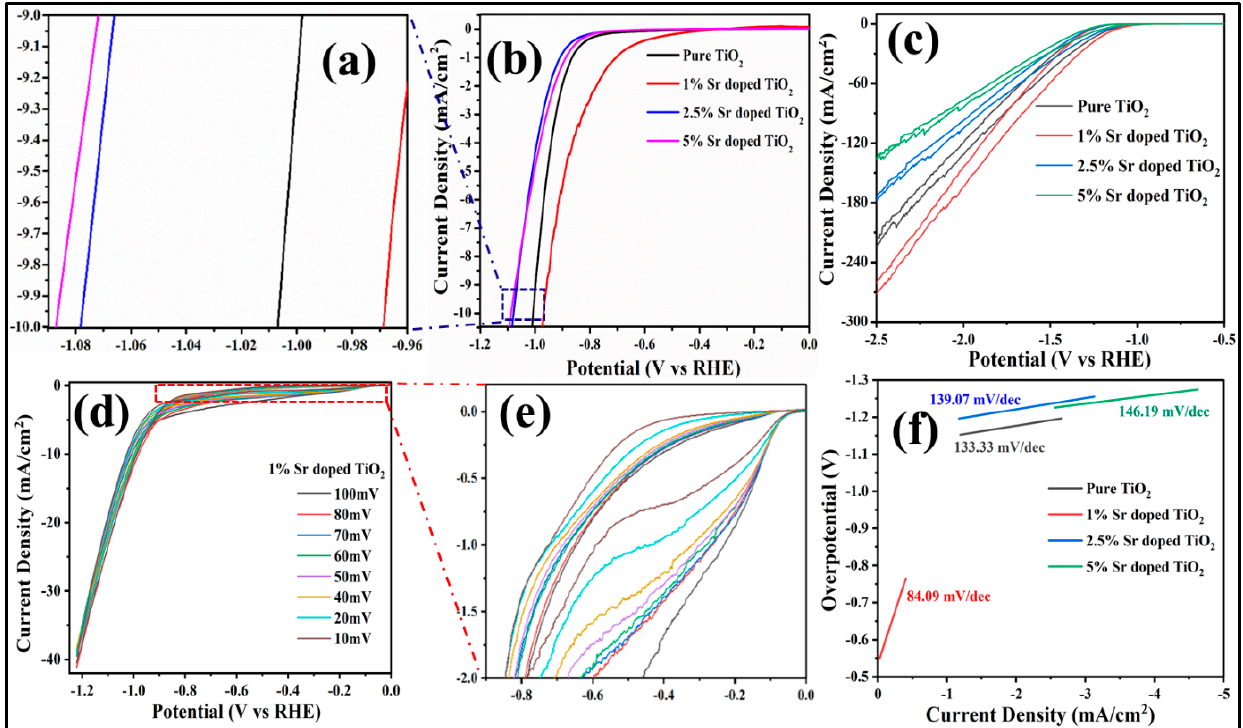
Figure 11. ( a – c ) shows the LSV and CV plots of HER of as-synthesized pristine TiO 2 and 1%, 2.5% and 5% Sr-doped TiO 2 ; ( d , e ) shows the CV plots of 1% Sr-doped TiO 2 toward HER; ( f ) shows HER Tafel plots of pristine TiO 2 and 1%, 2.5% and 5% Sr-doped TiO 2 Table 3. HER and OER electrodic parameters of pristine and Sr-doped TiO 2 electrocatalysts. S.